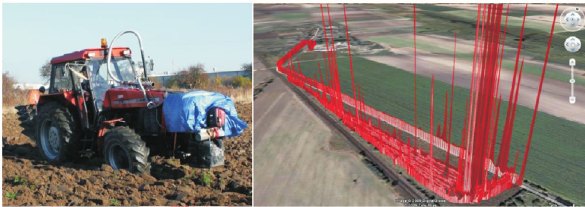
Fig. 9. Farm tractor during the tests under actual conditions of operation and the emission of NO shown on the tractor x